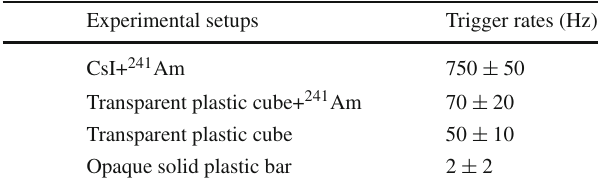
Table 2 Coincident trigger rates in different setups